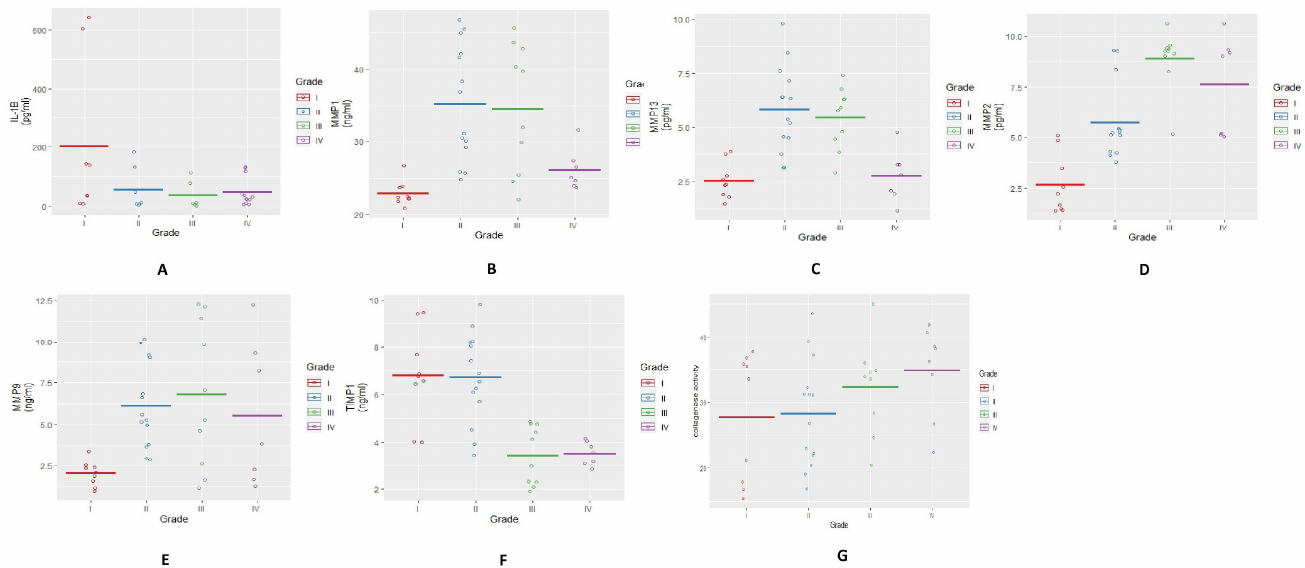
Figure 2. Estimation of MMP abundance (in protein forms) and activity in OA SFs. ( A ) a scatter plot depicting grade-wise estimation of IL-1 β ; the highest value of IL-1 β was found in SFs of KL grade-I. A grade-wise decline was seen in the levels; no statistically significant difference was noted in inter-grade comparison. ( B ) a grade-wise pattern of MMP-1 revealed maximum abundance in SFs from KL grade-II and III; a significant difference in MMP-1 was noted between KL grade-I and II ( p < 0.001), KL grade-I and grade-III ( p < 0.01) and KL grade-II and grade-IV ( p < 0.05). ( C ) depicts grade-wise estimation of MMP-13; the highest levels were found in SFs from KL grade-II and III; statistically significant difference in MMP-13 was noted between KL grade-I and grade-II ( p < 0.001), KL grade-I and III ( p < 0.001), KL grade-II and IV ( p < 0.001) and KL grade-III and grade-IV ( p < 0.01). ( D ) a grade-wise expression of MMP-2 showed maximum abundance in KL grade-III samples; a marked difference was seen between KL grade-I and II ( p < 0.001), KL grade-I and III ( p < 0.001), KL grade-I and IV ( p < 0.001) and KL grades-II and III ( p < 0.001). ( E ) a grade-wise estimation of MMP-9 revealed the highest level in moderate OA SFs (KL grade-II and grade-III). In inter-grade comparison, a significant difference was noted between KL grade-I and KL grade-II ( p < 0.05) and also between KL grade-I and grade-III ( p < 0.05). ( F ) demonstrates a grade-wise estimation of TIMP-1 level; higher levels were seen in early grade samples (KL grade-I and II); in inter-grade comparison, a marked difference was noted between KL grade-I and III ( p < 0.001), KL grade-I and IV ( p < 0.001), KL grade-II and III and KL grade-II and IV ( p < 0.001). ( G ) shows a grade-wise MMP activity measured using synthetic substrate FALGPA; maximum activity was estimated in SFs from KL grade-II and III, while the lowest activity was found in KL grade-I SFs. No significant difference was noted in inter-grade